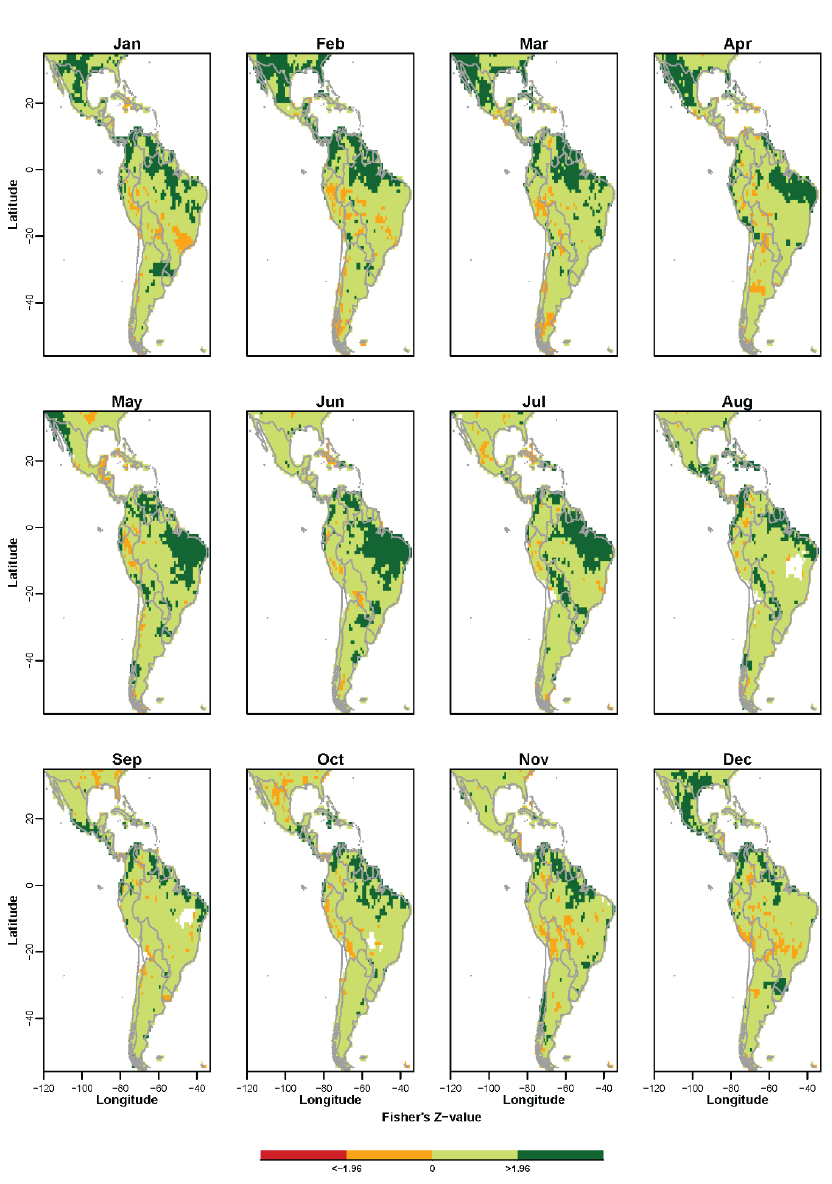
Figure 2. Monthly difference in forecast skill (Pearson correlation) between the forecast SPI3 at 3-month lead time (using the mean of the ensemble) and climatological SPI for the hindcast period (1981–2010). Values are indicated in the color bar: 1.96 is the statistical significance at the 5% significance level.